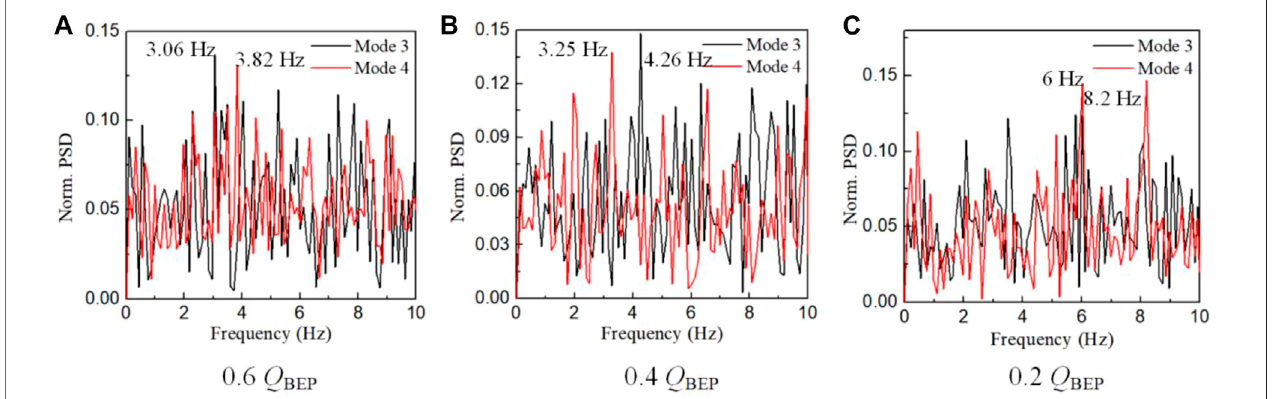
FIGURE 11 | FFT distribution of the third mode and the fourth mode. (A) 0.6 Q BEP , (B) 0.4 Q BEP , (C) 0.2 Q